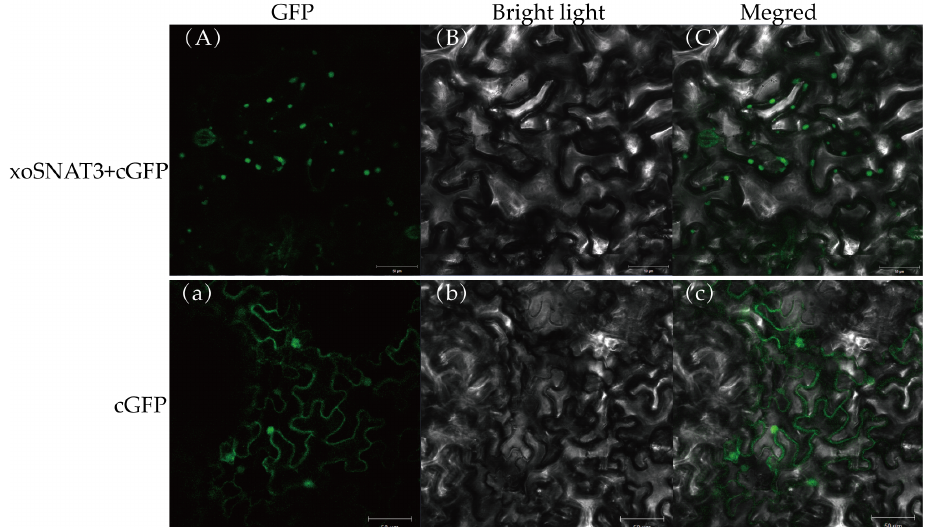
Figure 5. Localization of xoSNAT3 in tobacco cells. ( A , a ) Fluorescent images of xoSNAT3 ‐ GFP and GFP. ( B , b ) Bright Light filed of xoSNAT3 ‐ GFP and GFP. ( C , c ) Migration images of xoSNAT3 ‐ GFP and GFP. Recombinant plasmid with EHA105 was injected into 3 ‐ week ‐ old tobacco leaves, and the GFP signal was observed by confocal imaging.